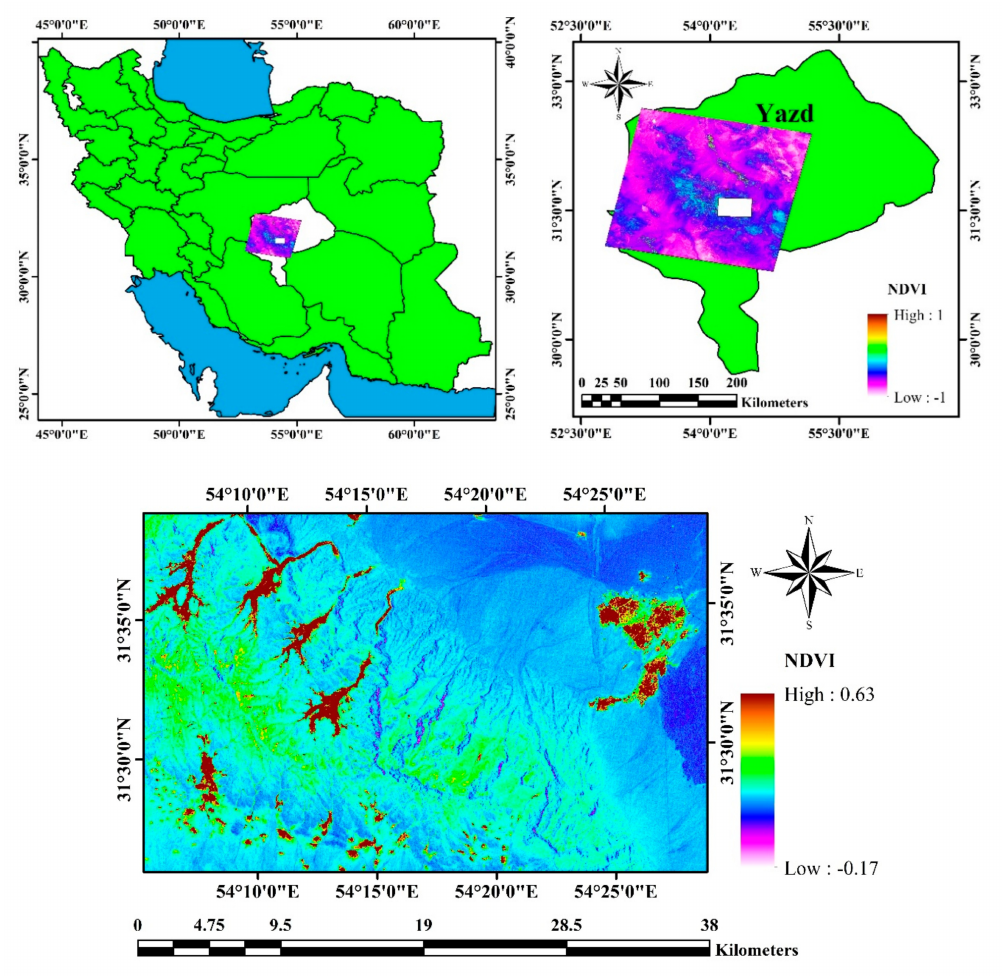
Figure 1. Location of study region in Iran and Yazd